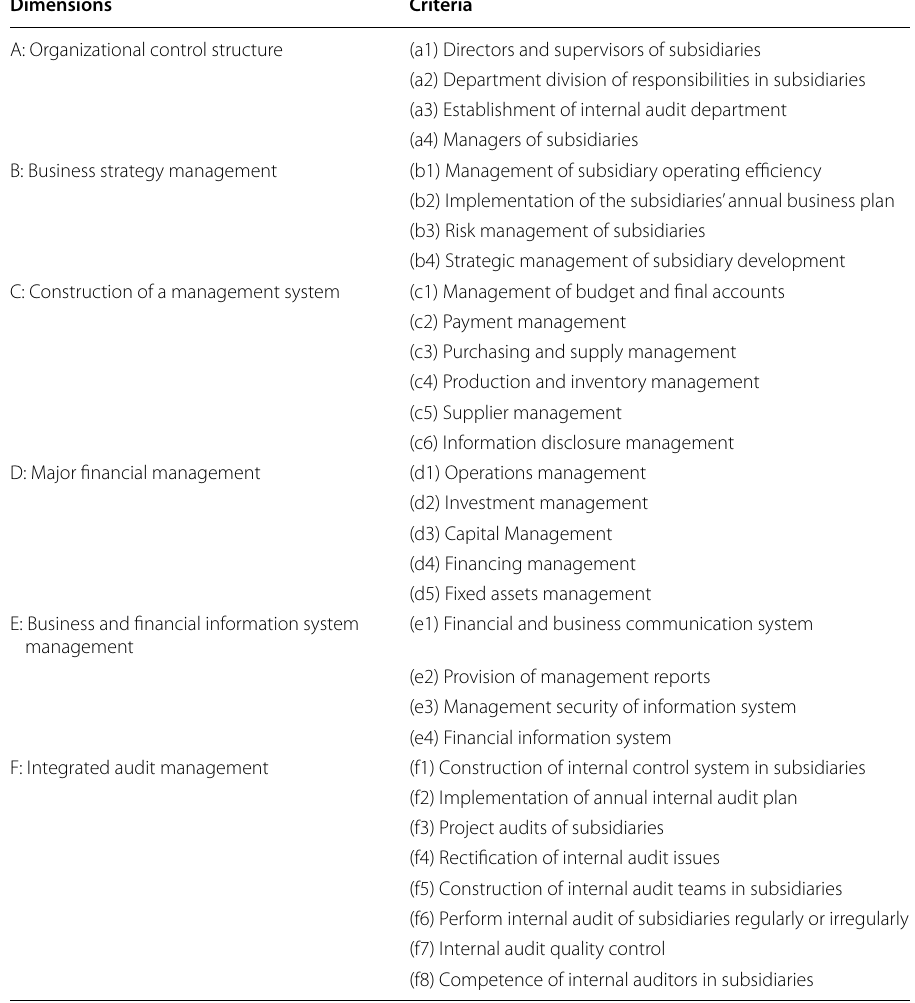
Table 1 Criteria of supervision and management of subsidiaries for the pre-test